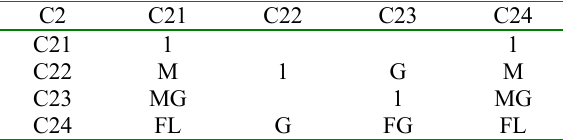
Table 10. Linguistic evaluation matrix of DM3 for C2 sub-criteria